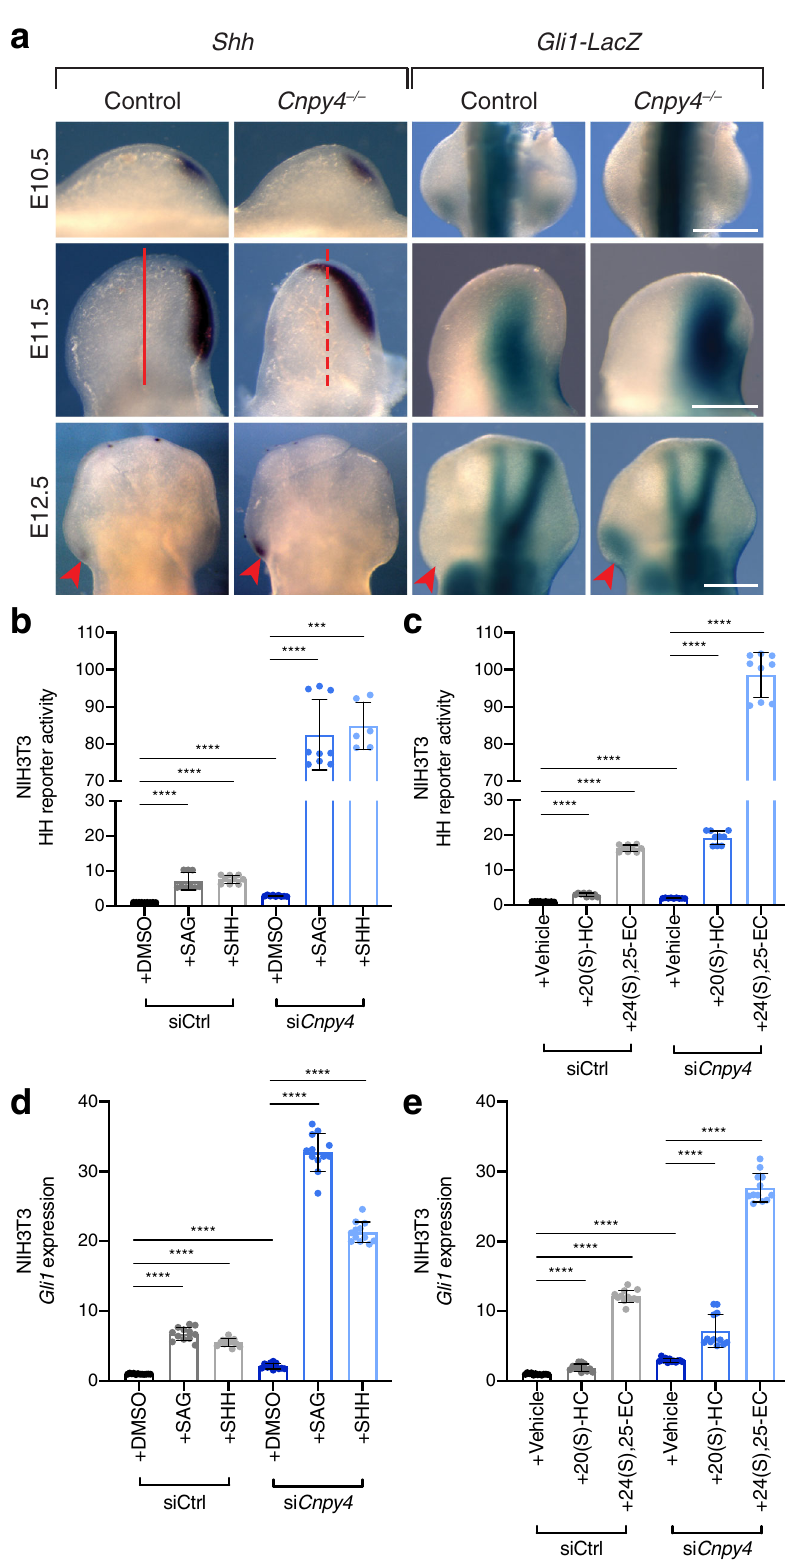
whether FGF signaling is also altered in the absence of CNPY4 by signi fi cantly different than that measured in the control MEFs, measuring the levels of FGF-dependent phosphorylation of Akt although the duration of Akt pathway activation was diminished and ERK in control and Cnpy4 − / − MEF cells (Supplementary in Cnpy4 − / − MEFs. Compared to the observed CNPY4- Fig. 6). The maximum magnitude of FGF-induced Akt and ERK dependent modulation of HH signaling, these effects on FGF phosphorylation in Cnpy4 − / − MEFs was not statistically signaling duration appeared quite modest. While we cannot NATURE COMMUNICATIONS| (2022) 13:2407